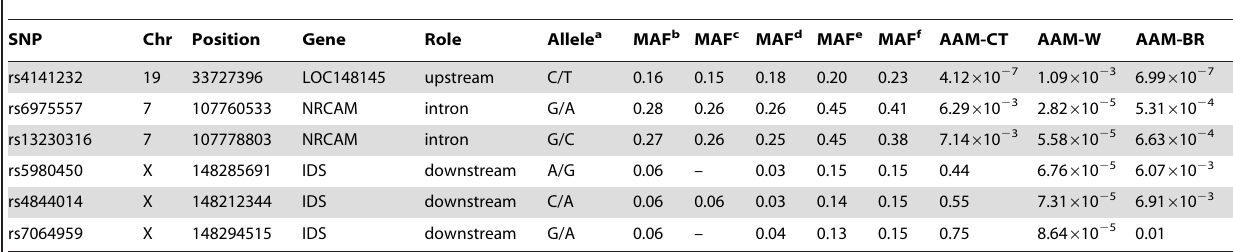
Table 3. Characteristics of SNPs bivariately associated with FNGPs and AAM.